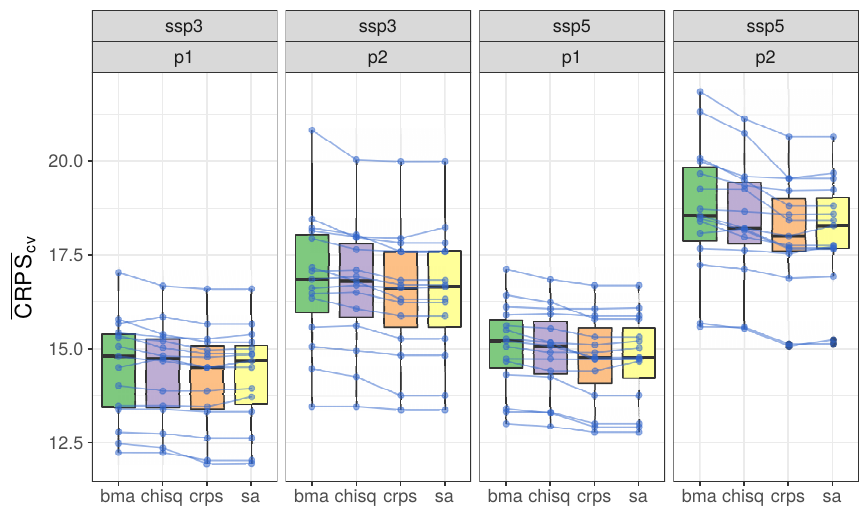
Figure 7. Parallel coordinated box-plots of CRPS cv ( α ) defined as in Equation (16), over 15 grid cells obtained from various α -weighting methods based on Bayesian model averaging (BMA), chi-square statistic (chisq), the continuous rank probability score ( crps ), and the simple averaging (sa) for the future periods P1 (2021–2060) and P2 (2061–2100) under the SSP3 and SSP5